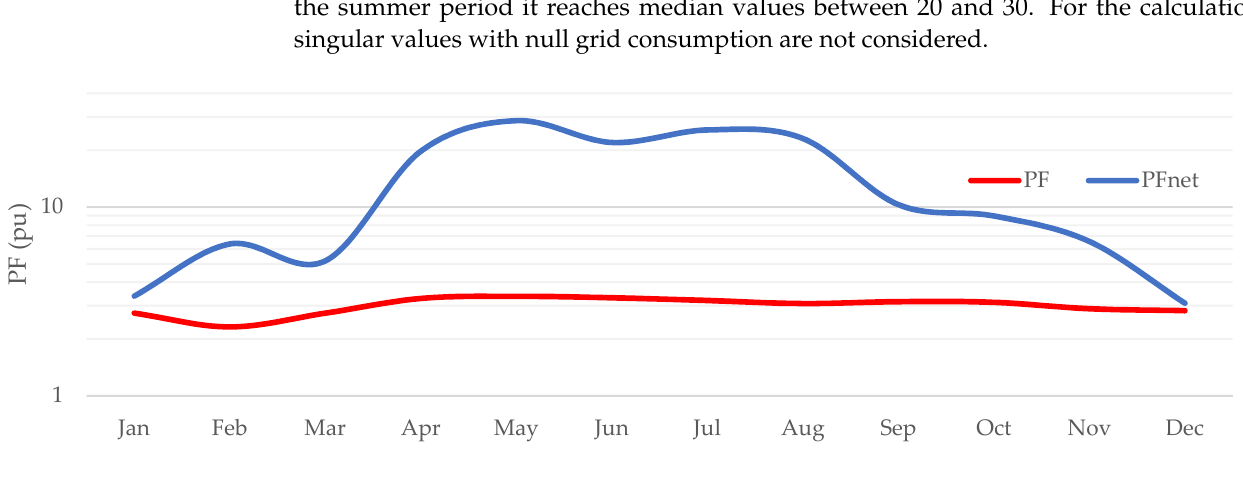
Figure 18. Monthly median daily PF per month, for common grid absolute and net versions.